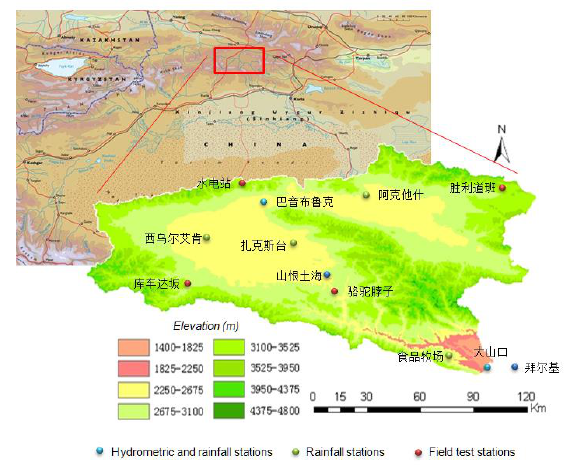
Figure 2. The location of preliminary field test stations (red) and controlling hydrometric/rainfall stations (blue) and rainfall stations (green).